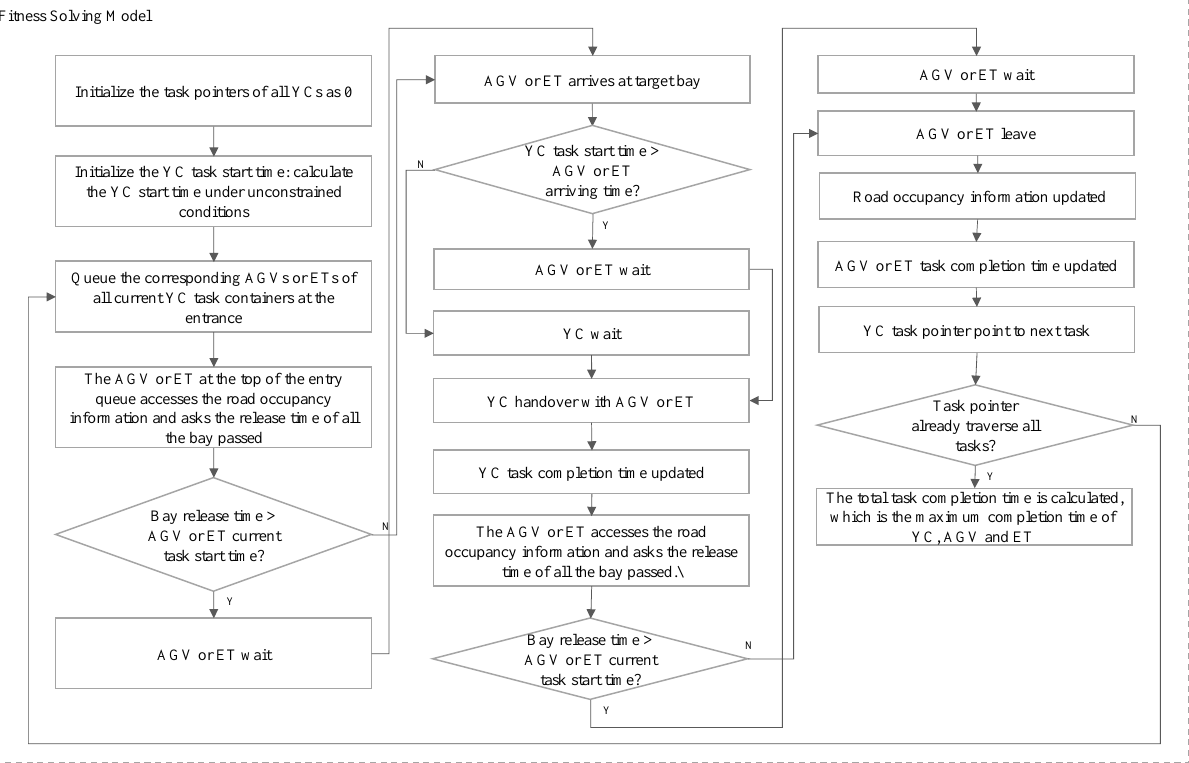
Figure 10. Dynamic solving process.